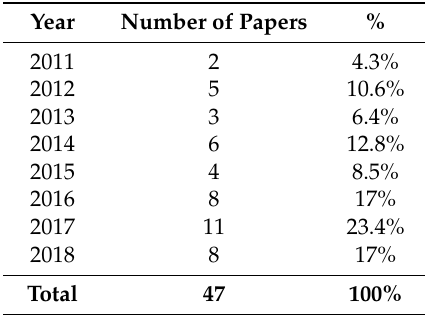
Table 1. Number of papers examined within 2011–2018.